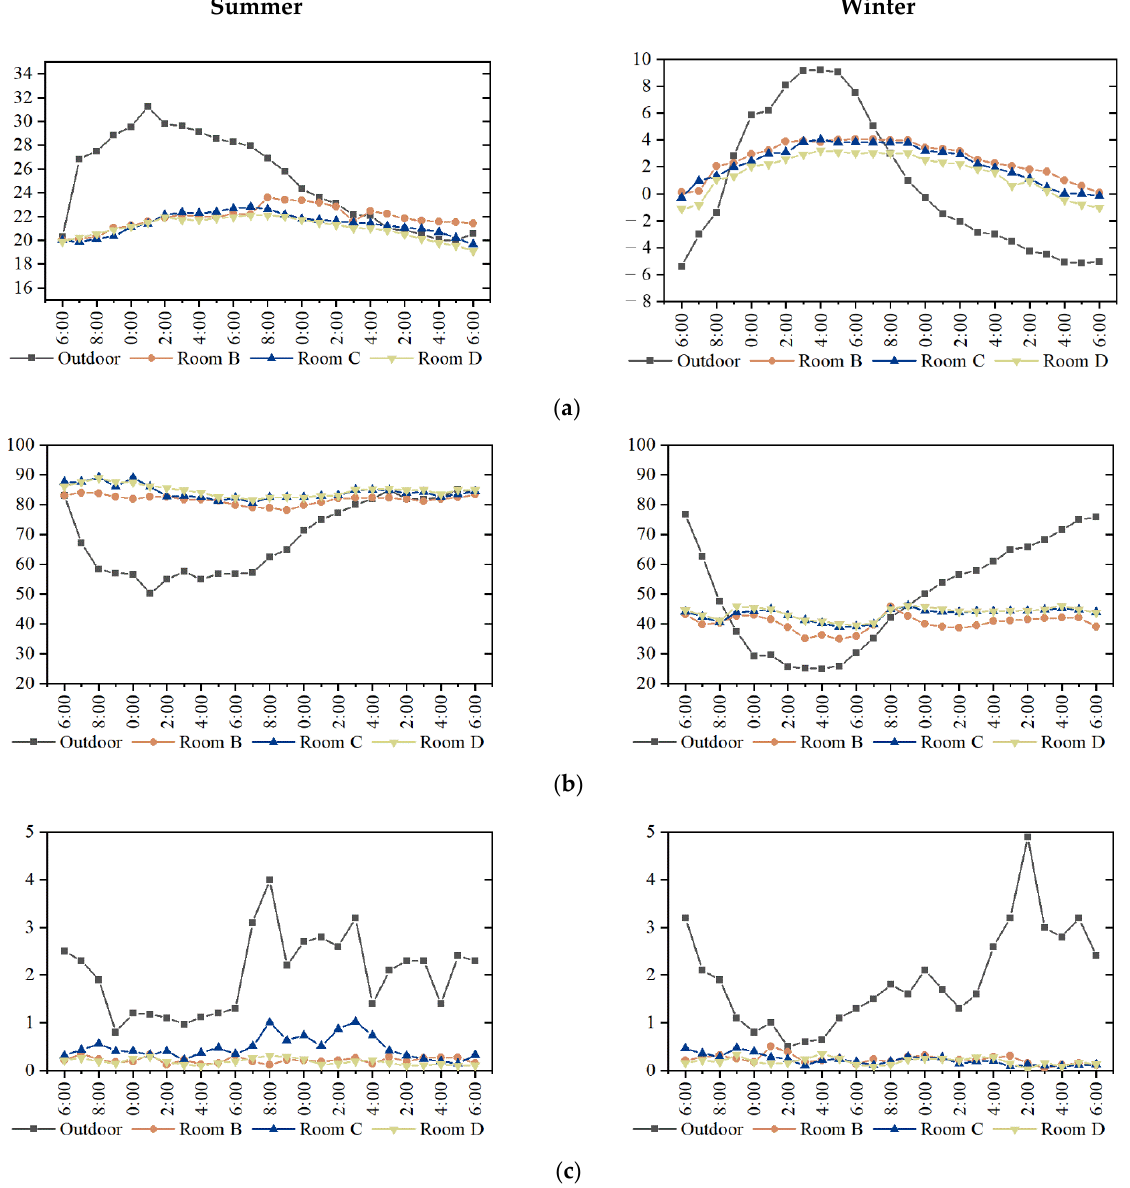
Figure 3. Measured outdoor and indoor thermal environment parameters. ( a ) The indoor and out-door air temperature (°C), ( b ) The indoor and outdoor humidity (%), ( c ) The in-door and outdoor wind speed (m/s).